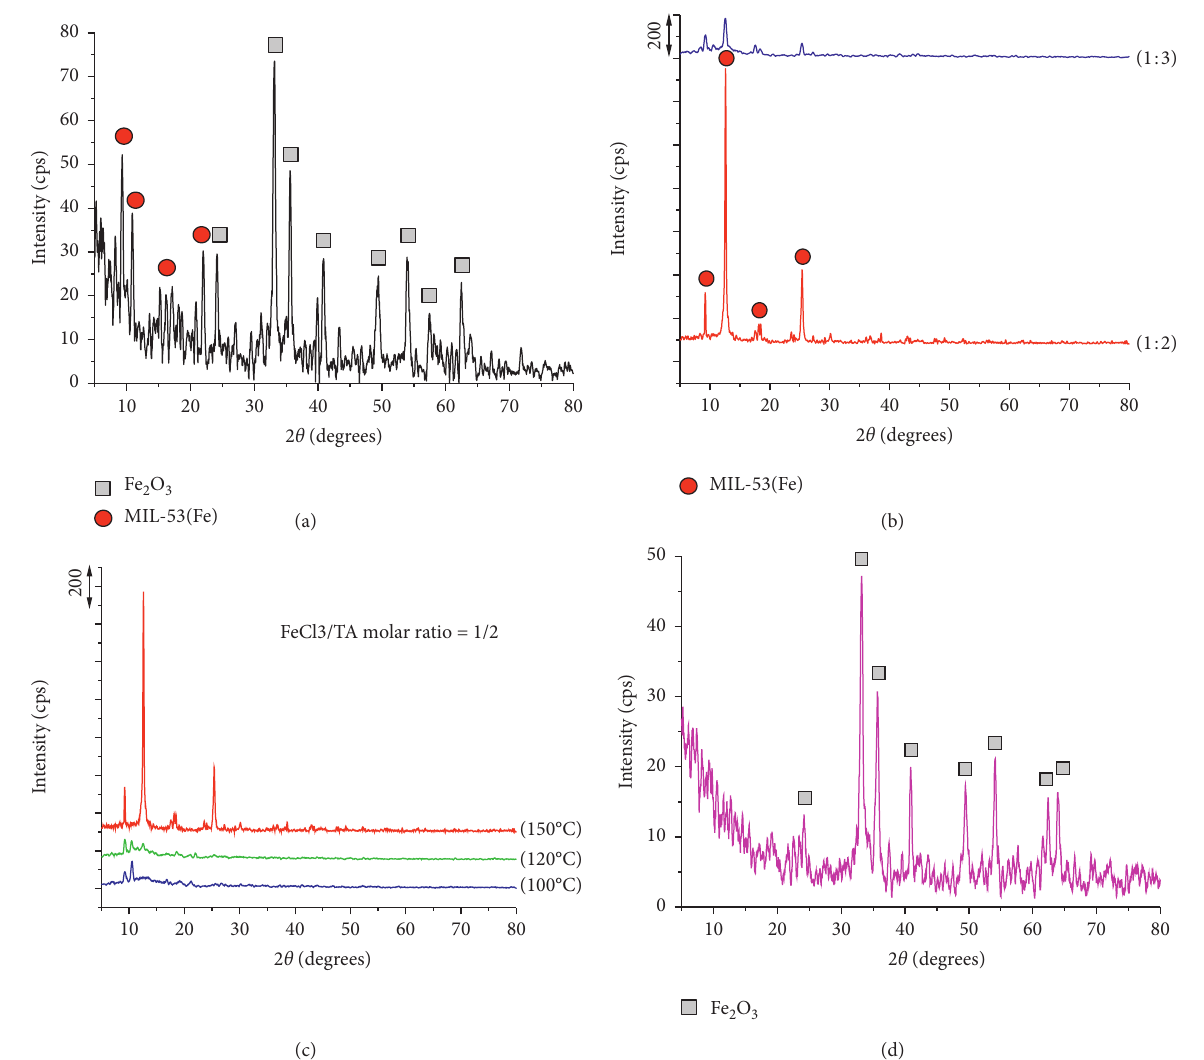
3 /TA molar ratio of 1/1; (b)